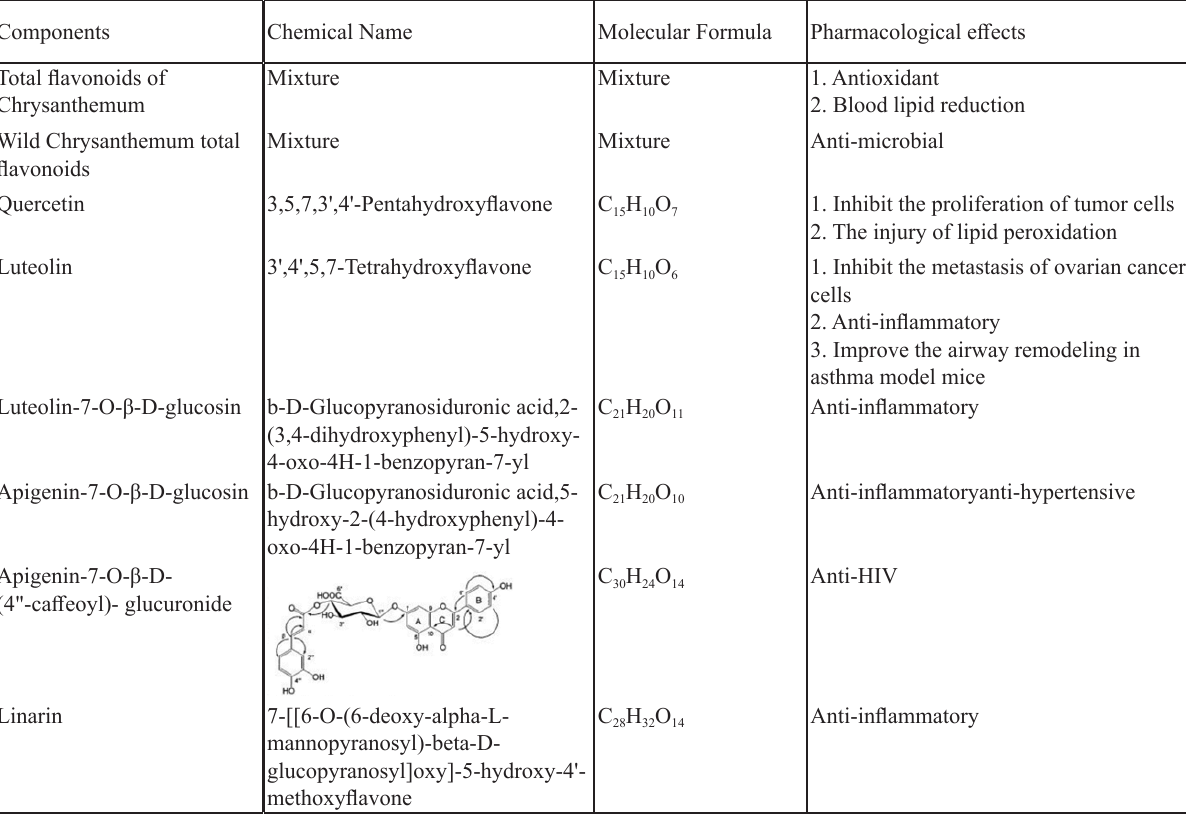
Table 2. Flavonoids in Chrysanthemum extract and their potential pharmacological